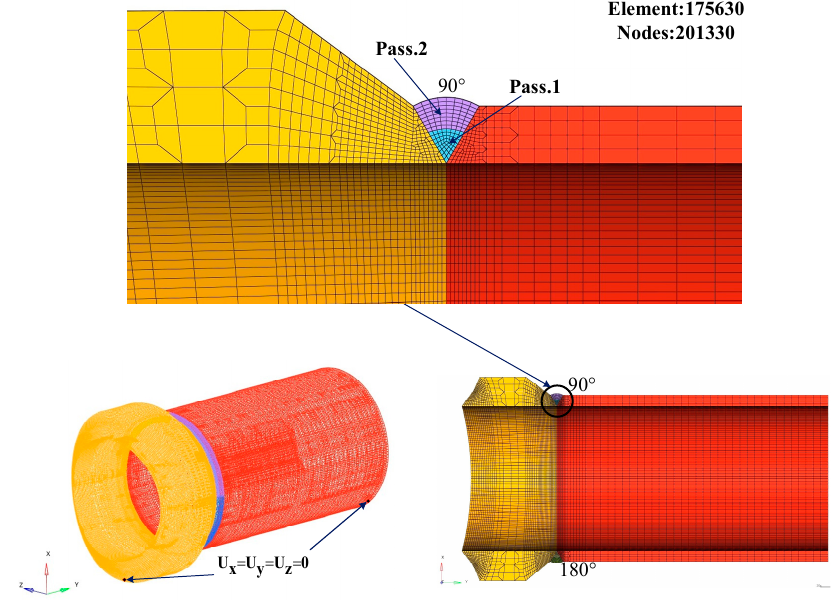
Figure 4. Finite element model meshing and boundary condition.